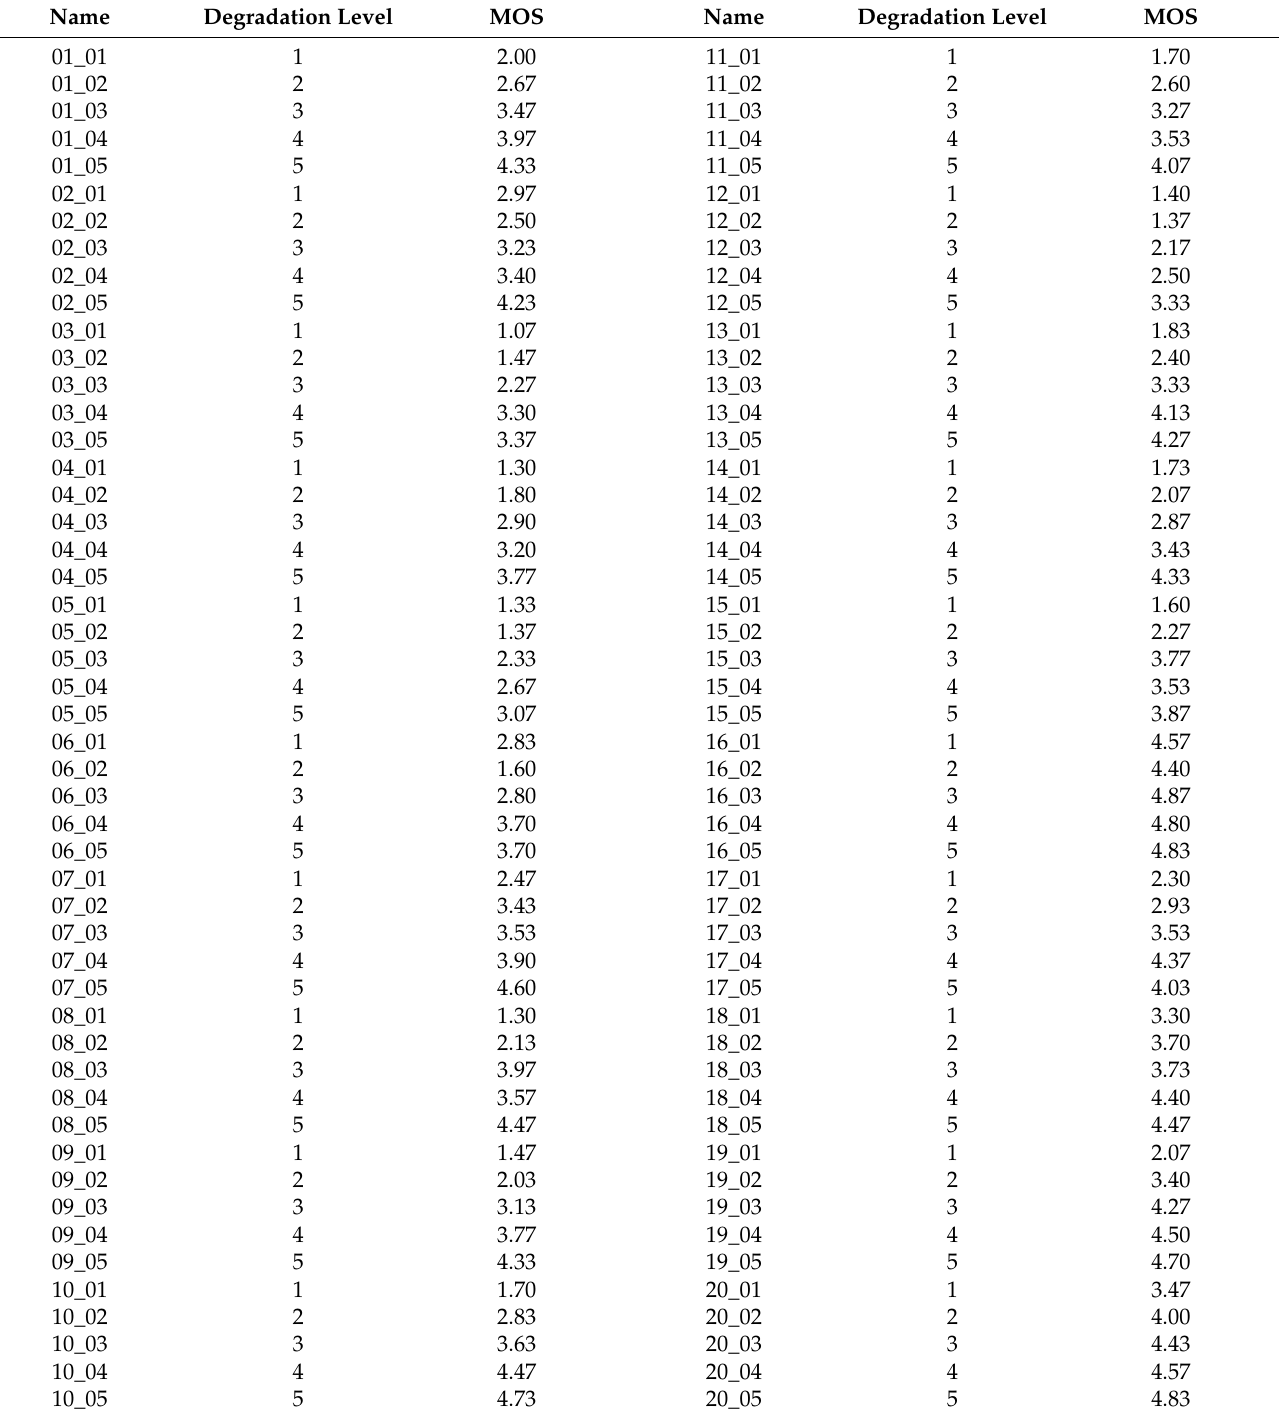
Table 1. Most Opinion Score obtained for each Stereo